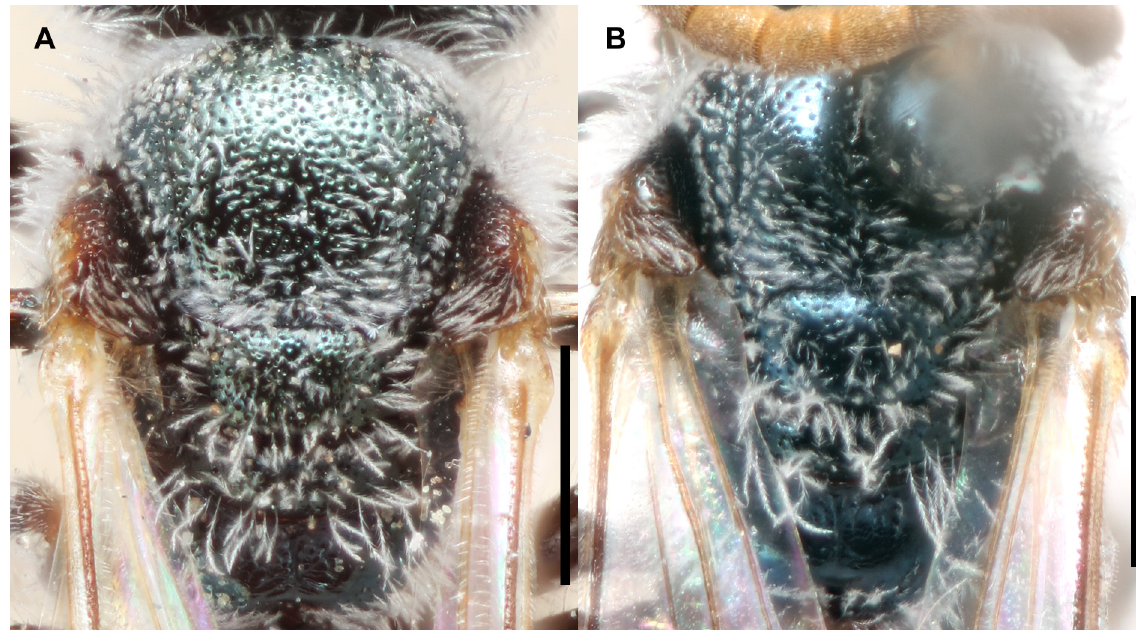
Fig. 105. Mesonotum. A . Lasioglossum gloriosum sp. nov., ♂, with mesoscutum densely punctate, tegula inner posterior margin strongly concave with crowded punctures, and metapostnotum rugae reaching posterior margin. B . L. indagator sp. nov., ♂, with mesoscutum sparsely punctate, tegula inner posterior margin weakly concave and more sparsely punctate, and metapostnotum rugae not reaching posterior margin. Scale bars = 0.5